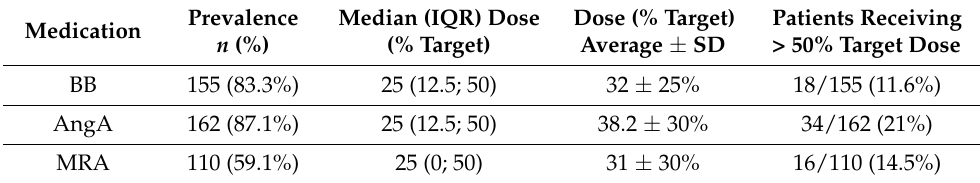
Table 2. Heart Failure (HF) medication groups prevalence and